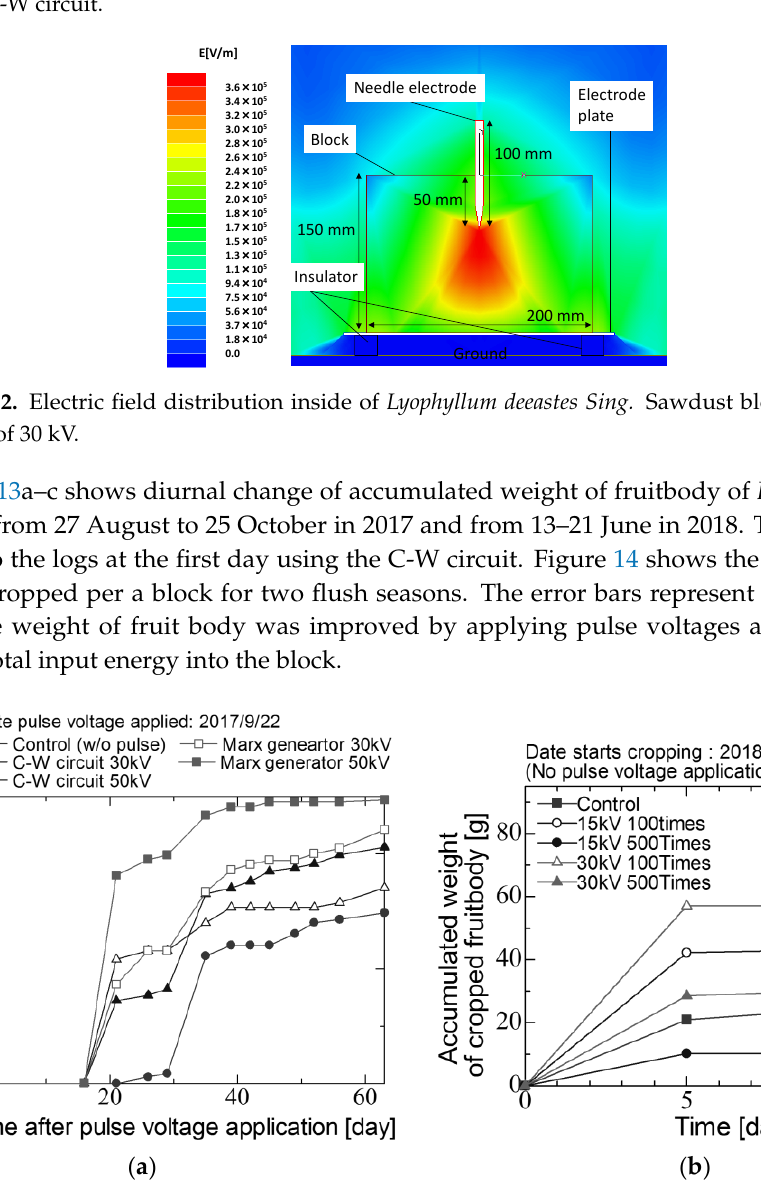
Figure 13. Diurnal change of the accumulated weight of fruitbody of Lyophyllum deeastes Sing in ( a ) 1st flush and ( b ) 2nd